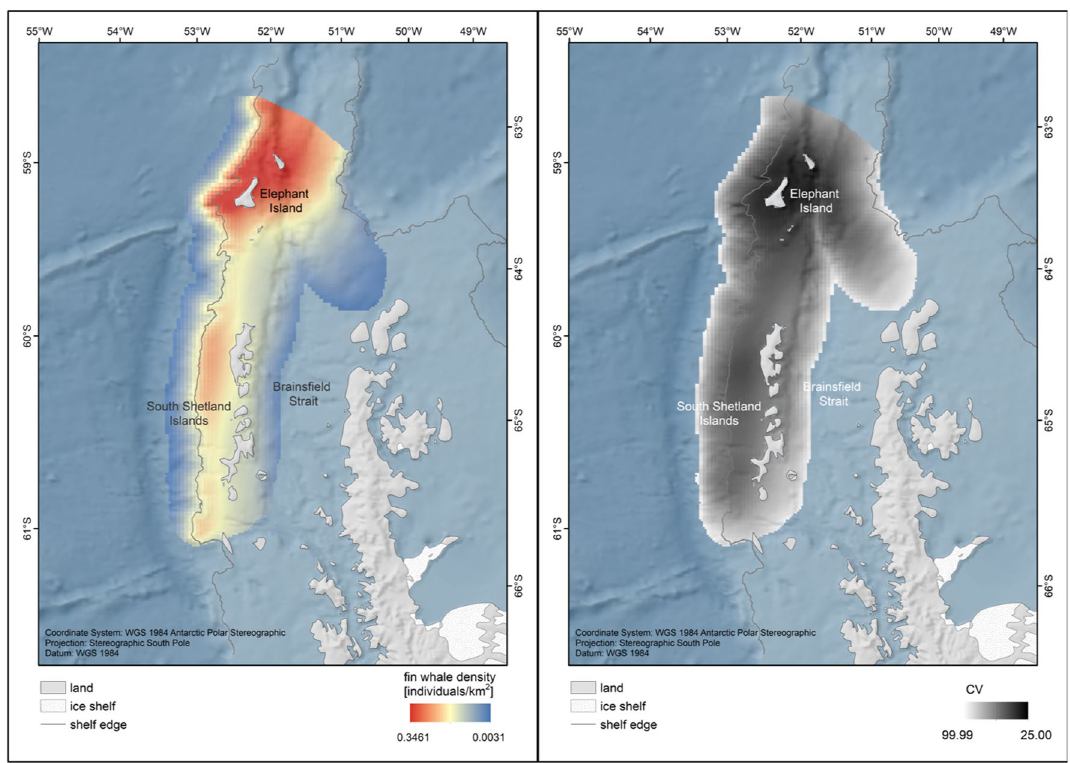
Figure 7. Fin whale distribution (left) and associated CVs (right) based on aerial survey data from RV Polarstern expedition PS112. Fin whale distribution as predicted by model g8 including a smooth of x and y and the distance to the shelf break as covariates. The spatial extent of the prediction was confined to only contain predictions with CVs < 100. The maps were composed using ESRI ArcGIS 10.6 (https:// www. esri. com/ en- us/ arcgis/ produ cts/ arcgis- deskt op/ resou